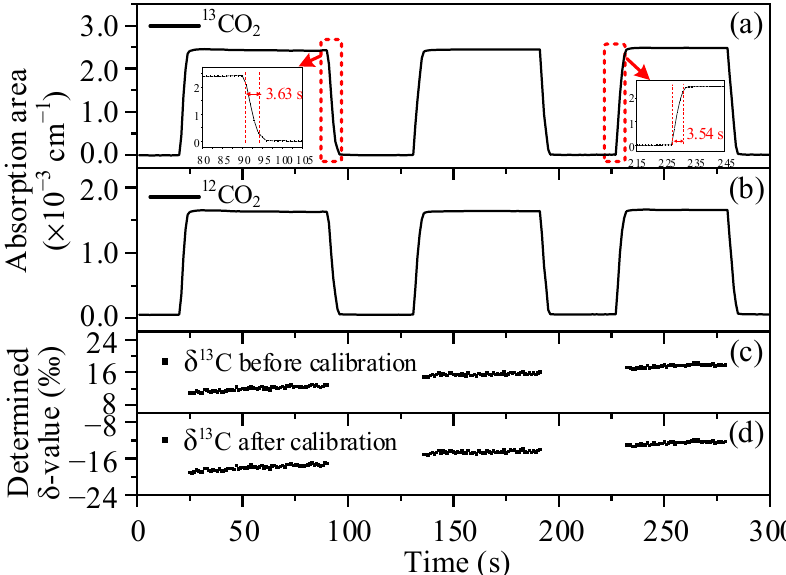
Figure 5. ( a ) Measured 13 CO 2 absorption areas and ( b ) measured 12 CO 2 absorption areas when the developed system alternately measures ambient air and cylinder gases with δ 13 C values of − 18.5‰, − 15.5‰, and − 12.5‰. ( c ) Calculated δ 13 C from absorption areas and uncalibrated temperature value. ( d ) Calculated δ 13 C based on calibrated temperature value.